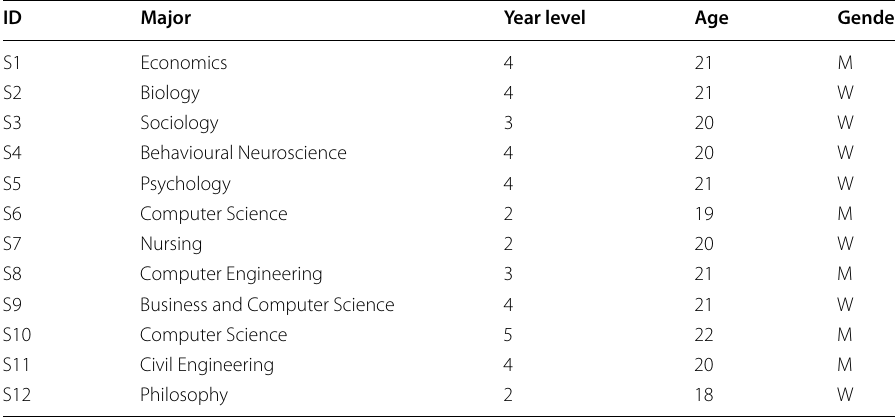
Table 3 Summary of the students’